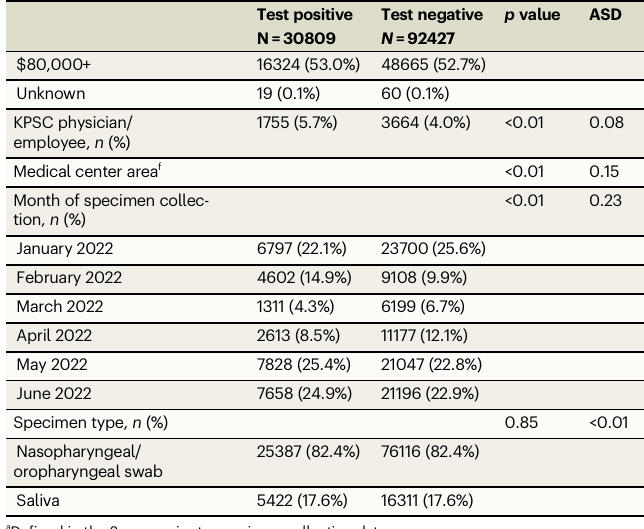
a De fi ned in the 2 yearsprior to specimencollection date. b De fi ned in the 1 year prior to specimen collectiondate. c Possible range: 0 – 29 43 . d Possible range: 0 – 1 44 . e De fi nedbasedonallavailablemedicalrecordsfrom1March2020tospecimencollectiondate. f Frequency and percent forthe19medical center areas arenotshown. χ 2 tests wereusedforcategorical variablesandtwo-sided,two-sample t tests wereusedfor continuousvariables. No adjustments were madeformultiple comparisons. ASD absolute standardized difference, N/A not